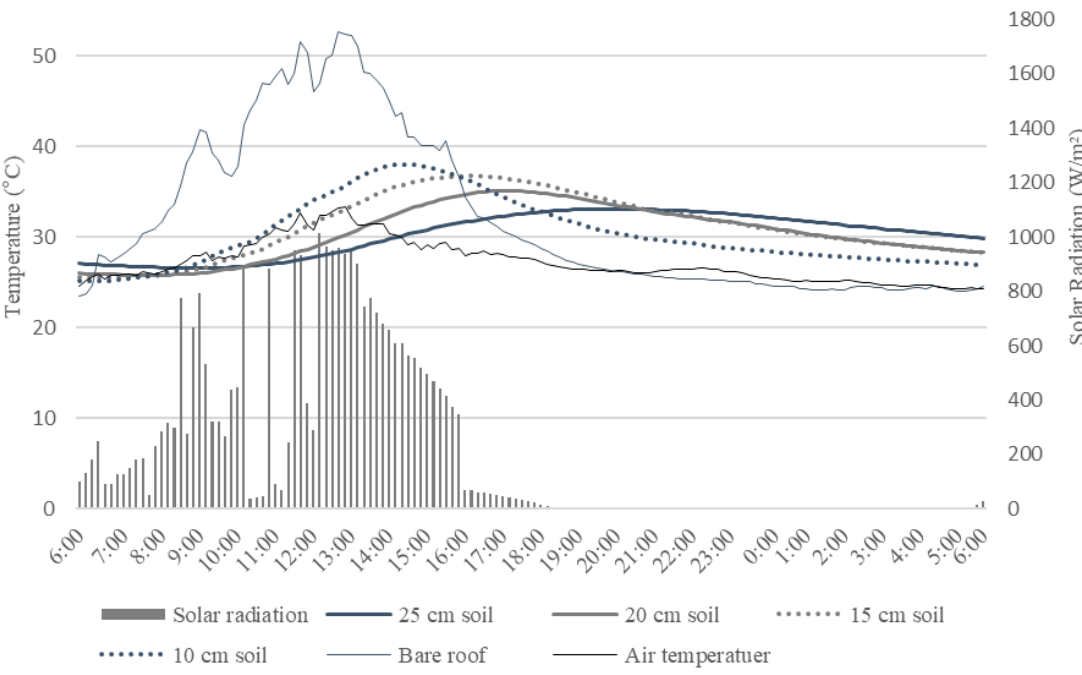
Figure 6. Temperatures and solar radiation in the cases of 10, 15, 20, and 25 cm conventional garden-soil roofs without plants (14 May 2017 05:59:44 to 15 May 05:49:44).